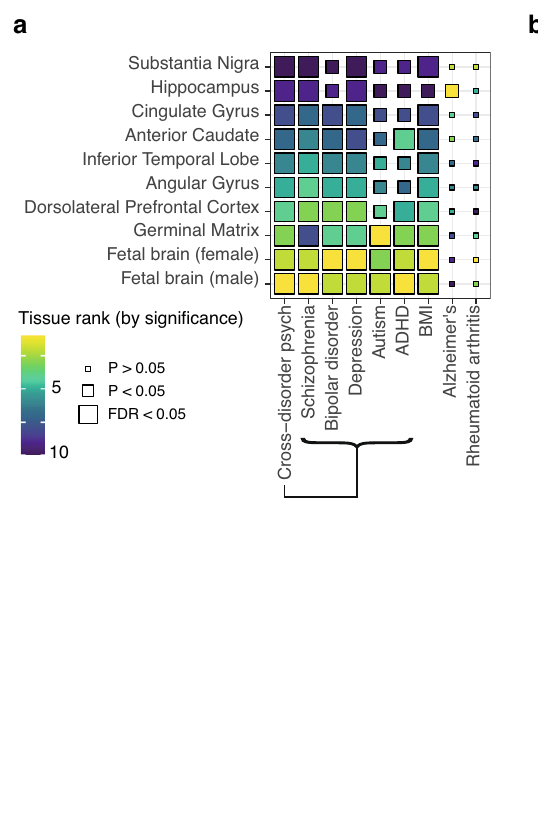
tests), taking the union of active elements in a given cell type as the annotation of interest.Tilesize,fromlargetosmall,indicates P -valuethresholdsfrom FDR <0.05 (signi fi cantafterBenjamini-Hochbergcorrectionforall88tissuestested,including those not shown here), through P <0.05 (nominally signi fi cant), to P ≥ 0.05 (not signi fi cant). Tile fi ll indicates the P -value rank within each disorder across all cells/ tissues to facilitate comparisons across results from differently-powered genetic association studies. See Supplementary Fig. 3 and Supplementary Data 1 for